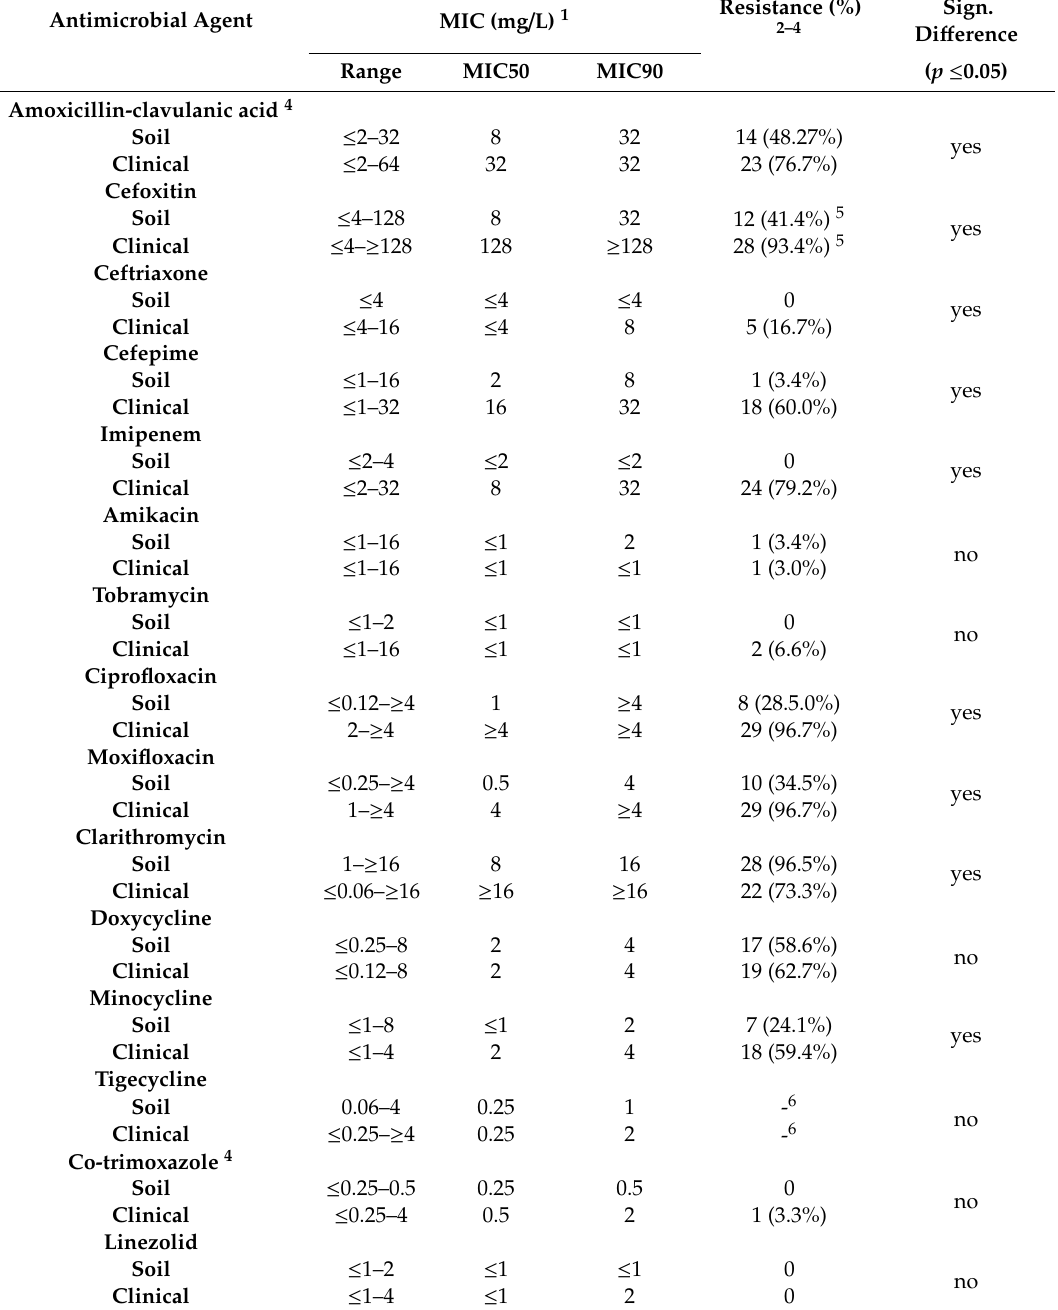
Table 2. Antimicrobial susceptibilities of 29 N. cyriacigeorgica soil strains and 30 N. cyriacigeorgica clinical strains. Comparison of resistance